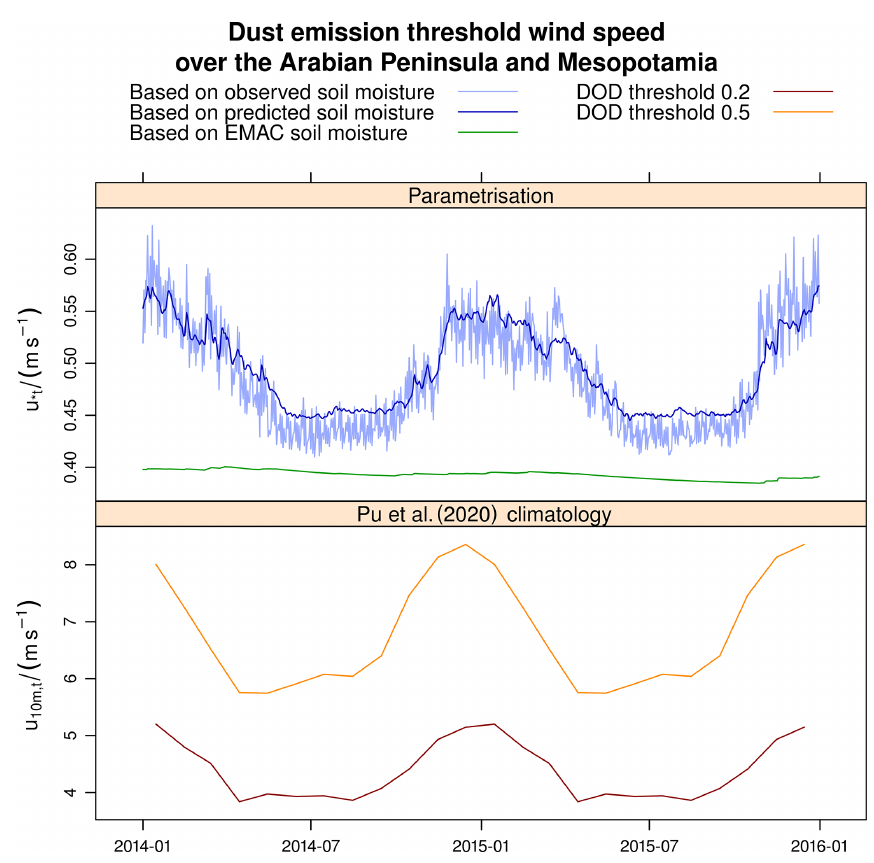
Figure 6. The surface friction velocity threshold above which dust is emitted, averaged over the Arabian Peninsula and Mesopotamia. The surface friction velocity threshold u ∗ t is computed using the parameterisation provided in the Appendix A. The threshold in terms of the wind speed at 10m altitude u 10m , t represents the climatological dataset retrieved by Pu et al. (2020).